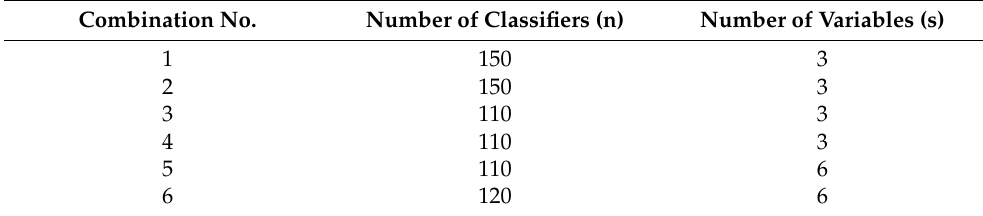
Table 5. Optimal parameters for RF models with different variable combinations. Combination